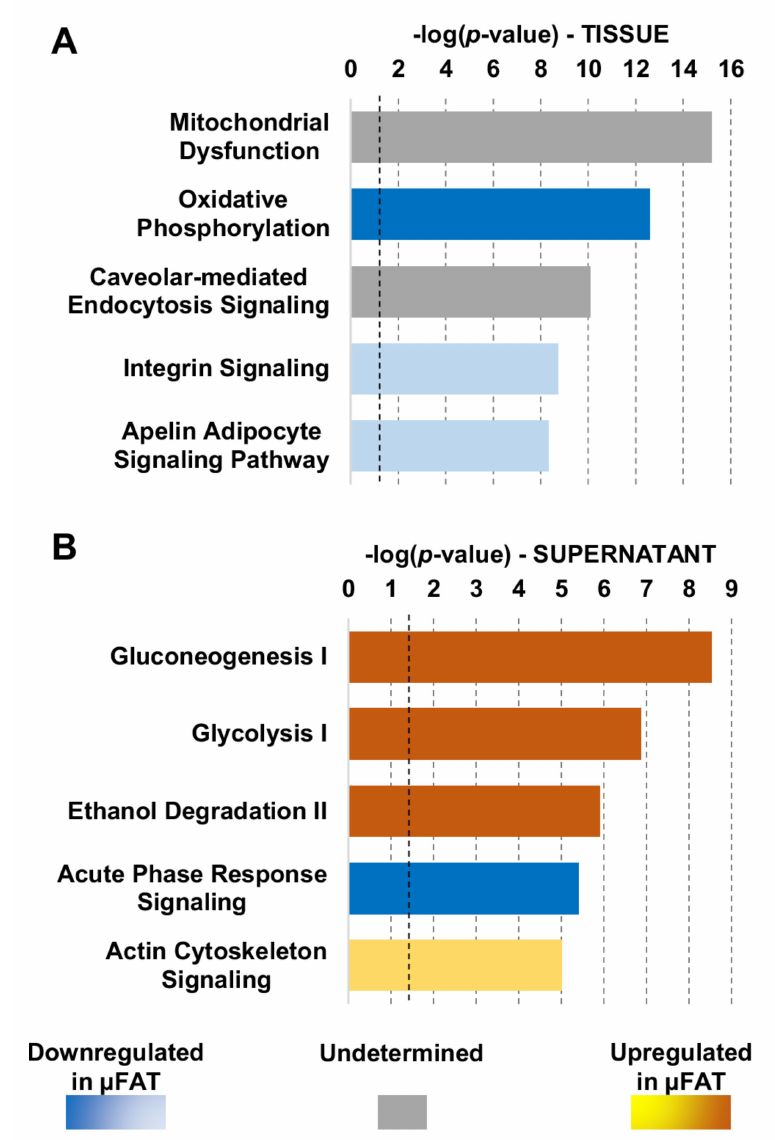
Figure 3. Dysregulated processes in protein tissues and supernatants after microfragmentation. ( A ) The top five most dysregulated pathways identified by IPA analysis in the µ FAT vs. LA tissues accordingly to p -value. Black dotted line indicates the threshold for p -value significance. Blue colour indicates a negative z-score and pathway inhibition in µ FAT, while grey colour indicates that IPA software was not able to assign a clear regulation regarding activation or inhibition. ( B ) The top five most dysregulated pathways in the µ FAT vs. LA supernatants accordingly to p -value. Black dotted line indicates the threshold for p -value significance. Blue colour indicates a negative z-score and pathway inhibition in µ FAT, while array of orange colour indicates a positive z-score and therefore pathway activation, with darker colour meaning stronger